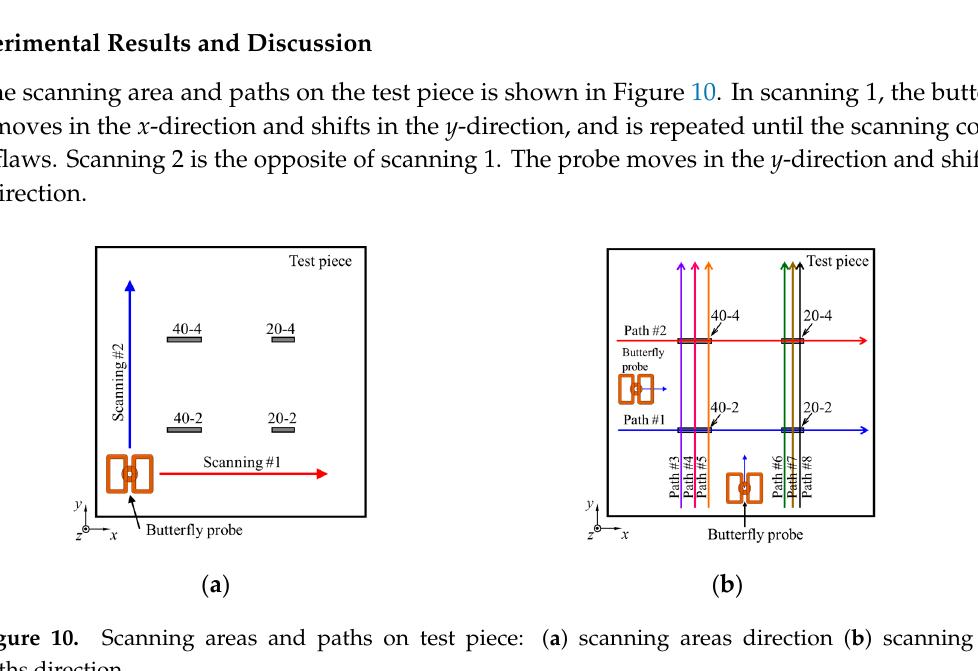
Figure 9. Scanning position of butterfly probe: ( a ) scanning 1; ( b ) scanning 2.